Question: What style of plot is this figure drawn as?
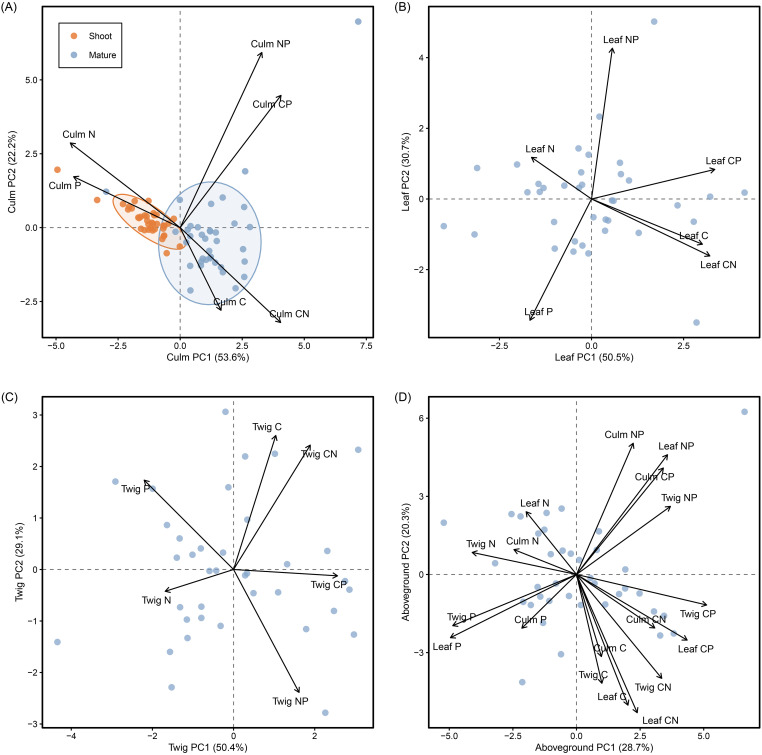
Answer: scatter